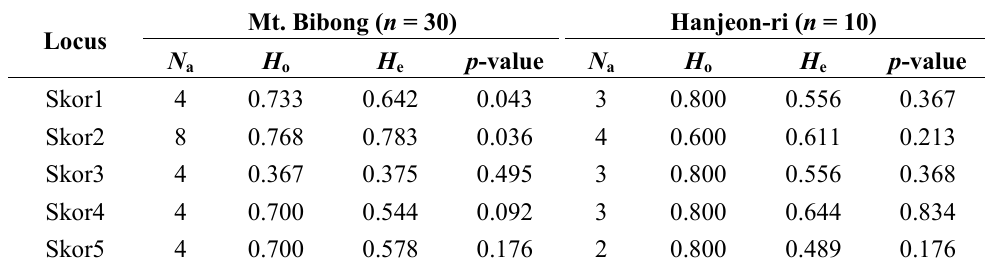
Table 1. Results of initial primer screening in Sophora koreensis . N H , observed heterozygosity; and H o equilibrium (HWE) tests are given for each